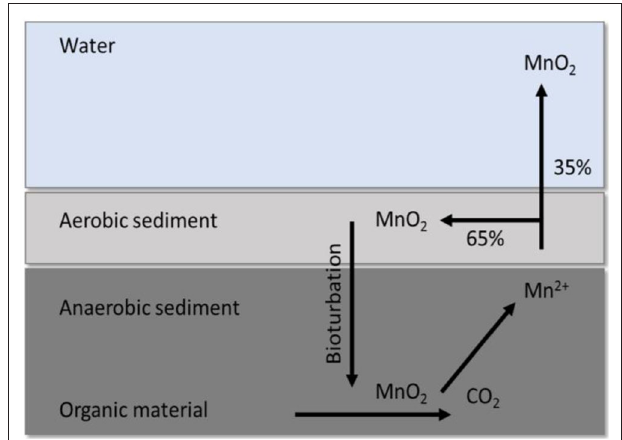
FIGURE 7 | Cycling between MnO 2 in aerobic sediment and Mn 2 + in anaerobic sediment, as well as release of a notable fraction back to the aqueous phase through dissimilatory Mn reduction by anaerobic bacteria. Adapted from Thamdrup et al.